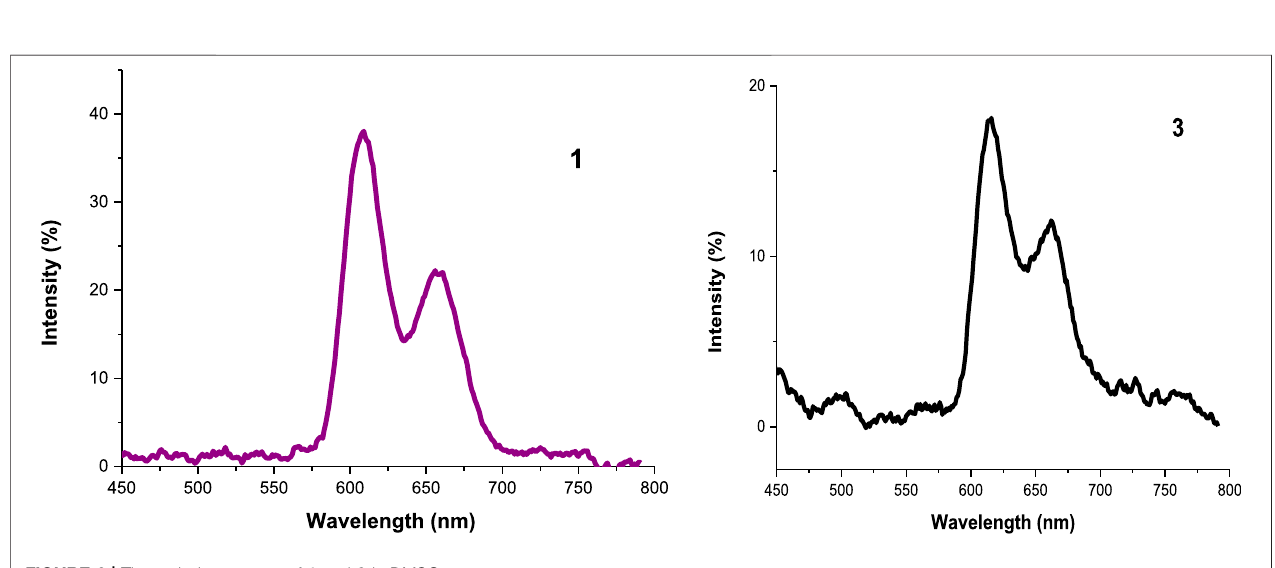
FIGURE 5 | TGA thermograms of DNDs, complex 4 and the nanoconjugates showing thermal stability after conjugation.